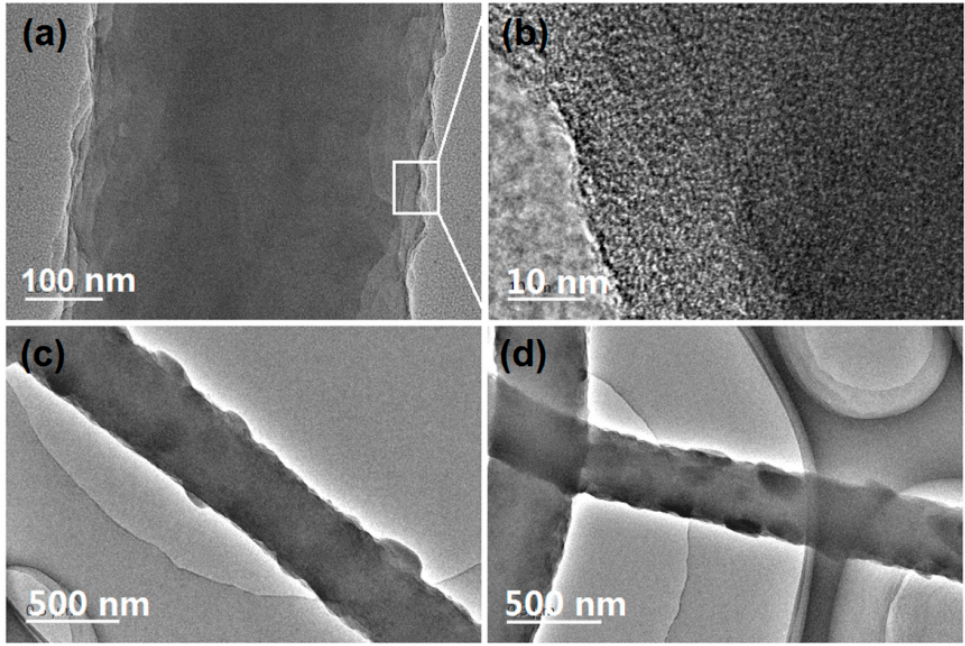
Figure 5. The TEM evaluations of the resultant nanofibers: ( a , b ) nanofibers of N1; ( c ) nanofibers of N2; ( d ) nanofibers of N3.